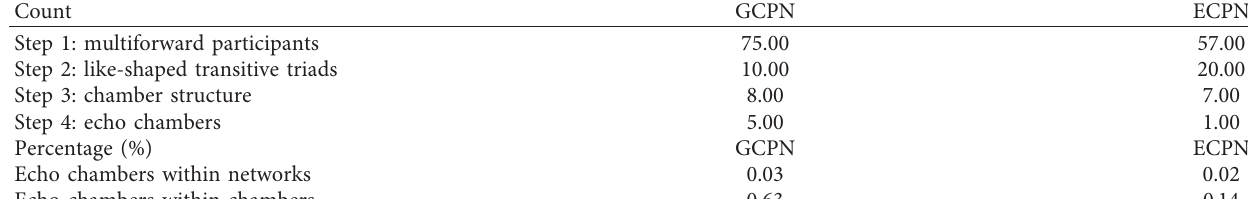
Table 2: The summary of echo chamber identification in participation